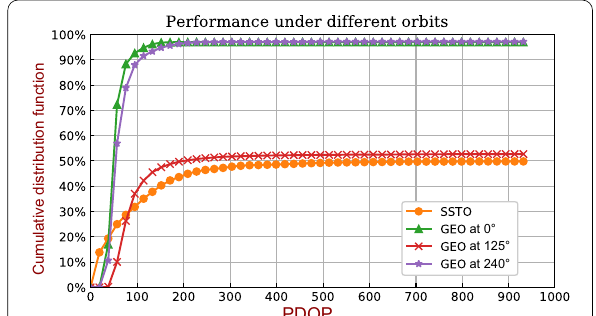
Fig. 12 Cumulative distribution function of PDOP values in scenario